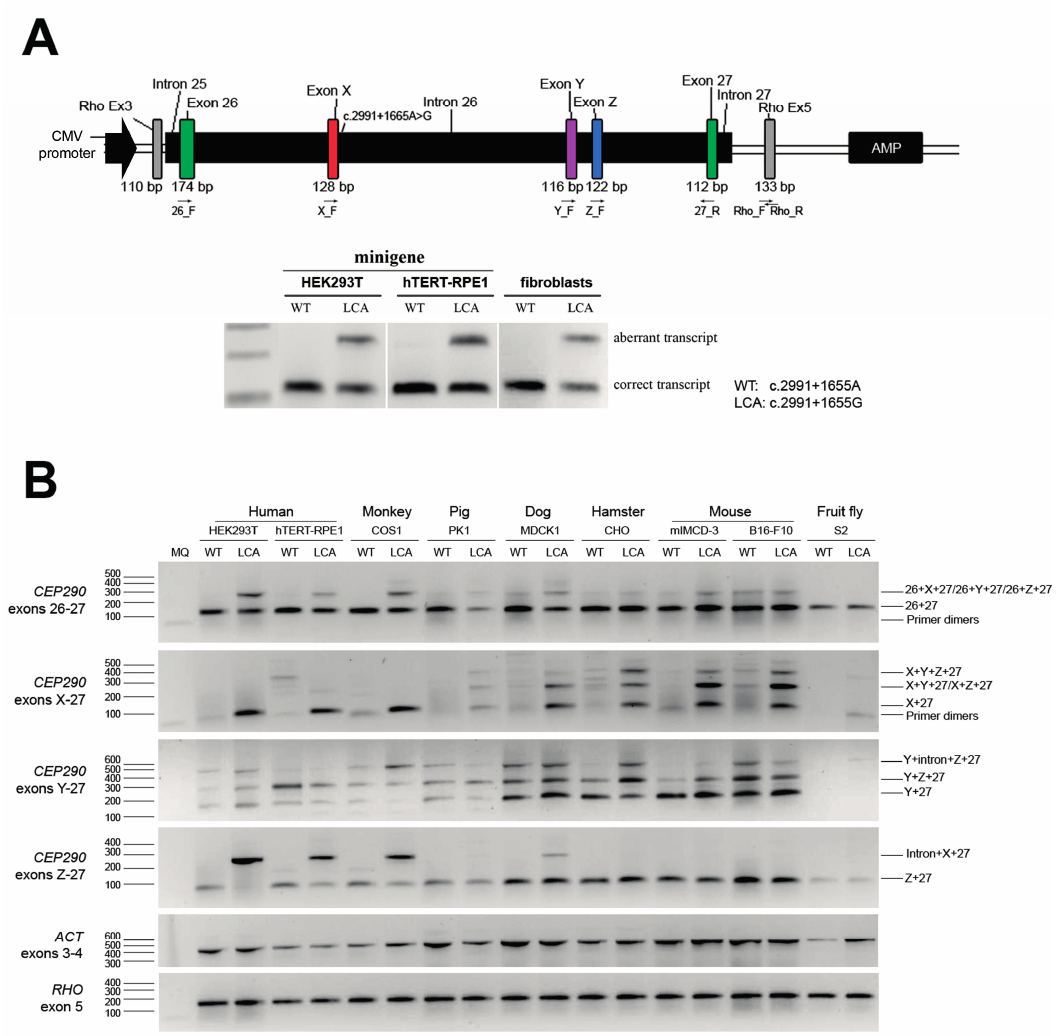
Figure 1. Assessment of CEP290 splicing upon overexpression of the minigenes in cells from different species. ( A ) Upper panel: Schematic representation of the position of the promoter and different cryptic exons within intron 26, as well as the primer localization in the wild-type (WT) and Leber congenital amaurosis (LCA), minigene construct carrying the intronic mutation; Lower panel: Splicing pattern detected after minigene expression in human HEK293T and hTERT-RPE1 cells compared to fibroblast cell lines of a healthy individual or an individual homozygously carrying the intronic CEP290 mutation; ( B ) Assessment of the splicing pattern of WT and LCA minigenes in several cell lines of different species via RT-PCR analysis. Actin ( ACT ) and rhodopsin ( RHO ) were used to normalize samples. MQ represents milli-Q water and was the negative control of the PCR reaction. For semiquantitative analysis of the gels, see Supplementary Figure